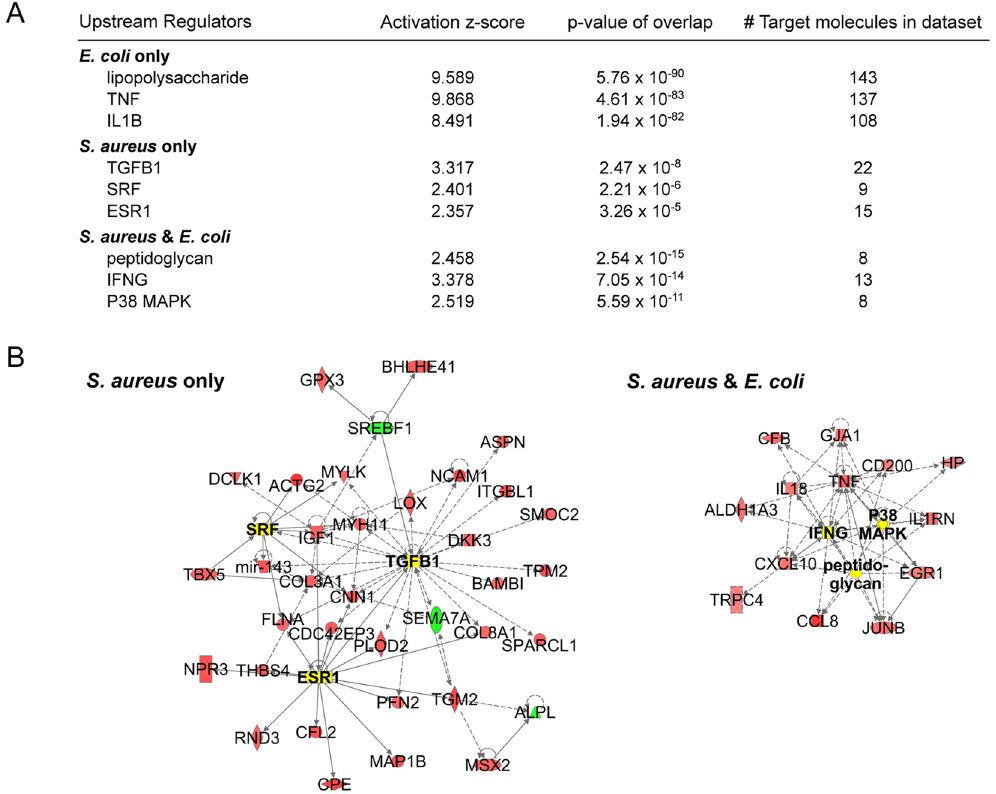
Figure 2. Ingenuity based identification of Upstream Regulators. ( A ) List and statistical significance of the 3 top-scoring upstream regulators as identified exclusively after E . coli or S . aureus infection or being commonly active during infection with both pathogens. ( B ) Graphical display of the regulatory networks governing the response towards an S . aureus infection (left) or that with both pathogens (right). Red and green underlay indicate up- or downregulation, respectively, while yellow highlights the up-stream regulators. Figure S2 shows the graphical display of the highly complex regulatory network during an E . coli